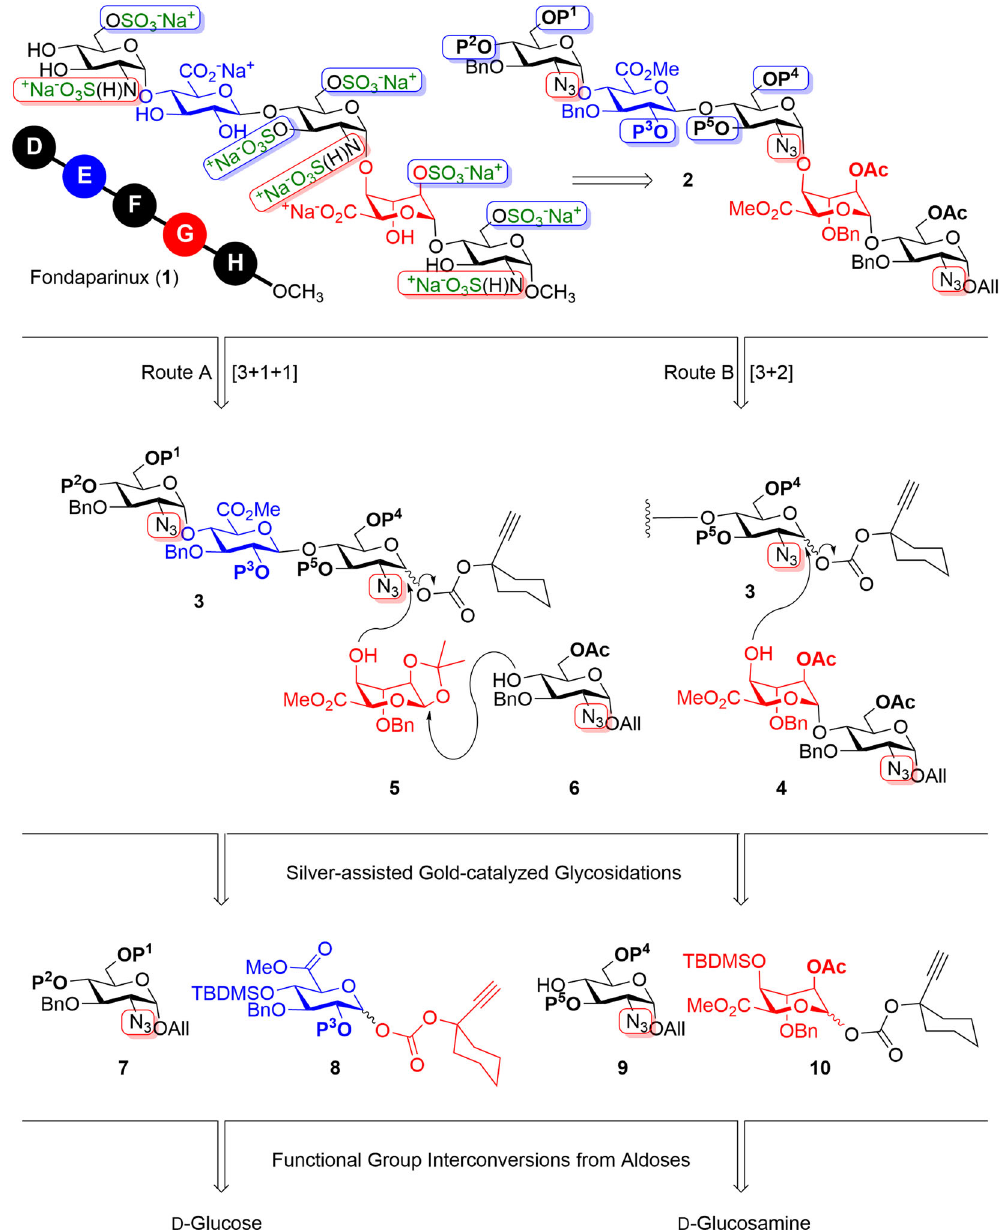
Fig. 1 Retrosynthesis of the pentasaccharide. Fondaparinux ( 1 ) can be synthesized from the advanced intermediate 2 which in turn can be synthesized by either [3 + 1 + 1] using 3 , 5 , 6, or [3 + 2] manner from compound 4 . Compounds 3 , 4 can be obtained from monosaccharides 7 – 10